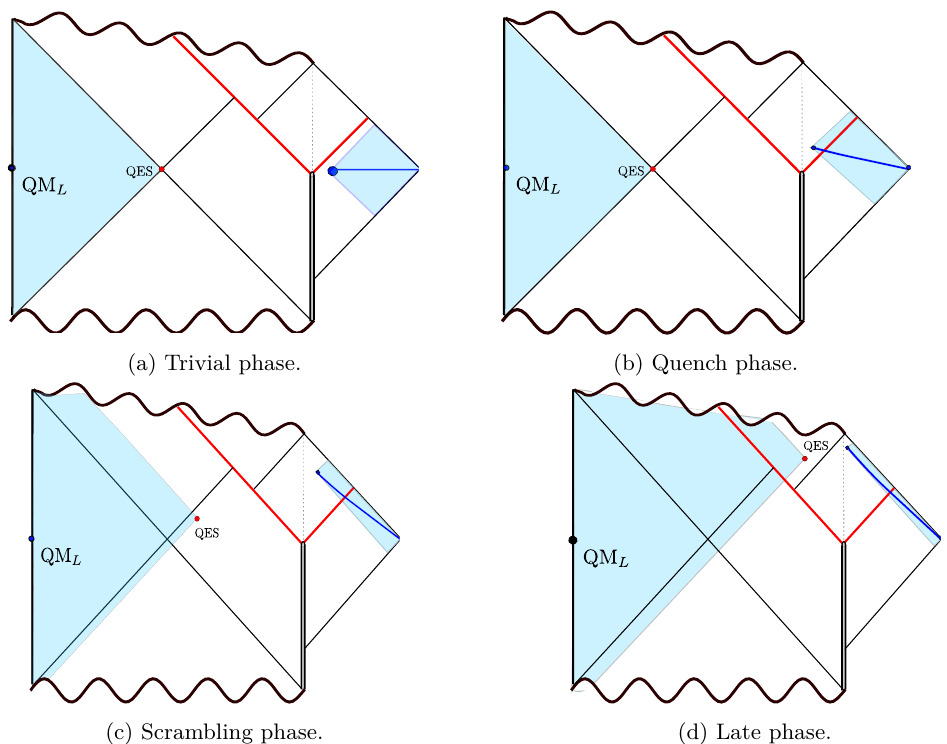
Figure 5. A sketch of the entanglement wedges for the different phases in the Page curve of semi-infinite intervals plus QM L